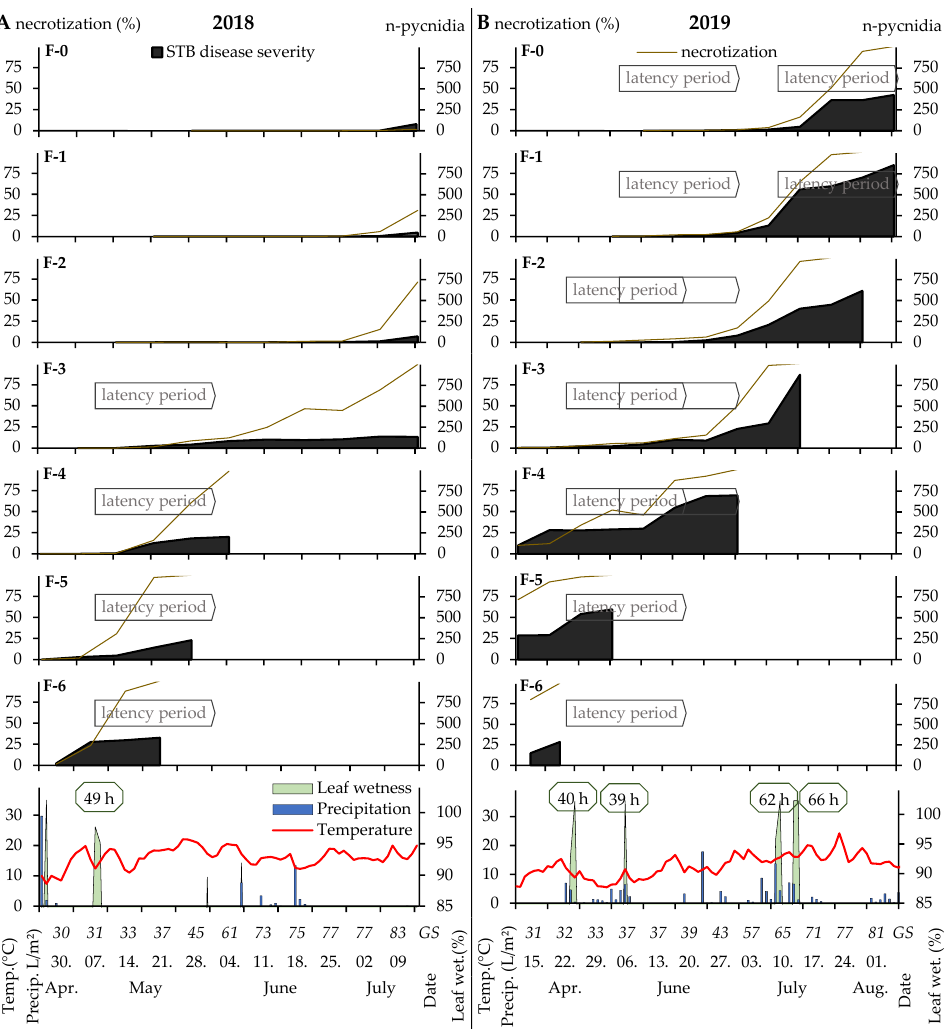
Figure 4. Epidemiological development of STB (n-pycnidia; black area) on the seven uppermost leaf layers in combination with the necrotized leaf area (%; gold line), prevailing weather conditions (temperature as red line; precipitation as blue bars; leaf wetness (%) as green area (duration of leaf wetness ≥ 98% is given in hours) as a function of the date), and growth stage of the survey years ( A ) 2018 and ( B ) 2019.